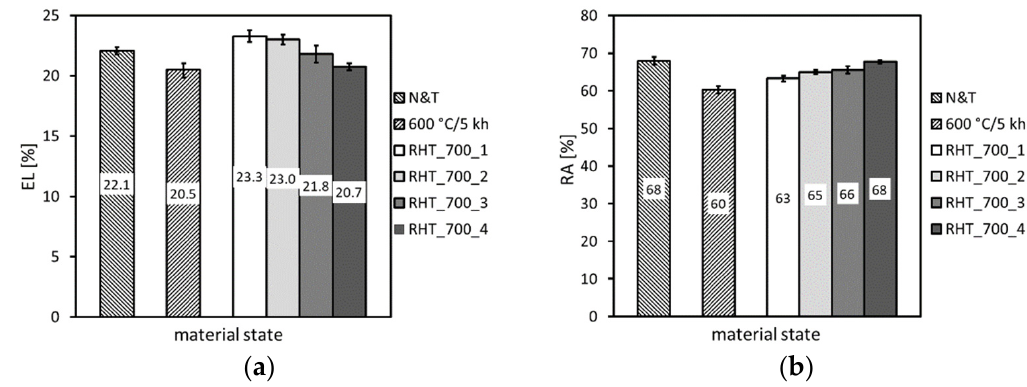
Figure 12. The effect of various heating up and cooling down conditions of the rejuvenation heat treatment at 700 °C for 1 h on ( a ) total elongation and ( b ) reduction of area.